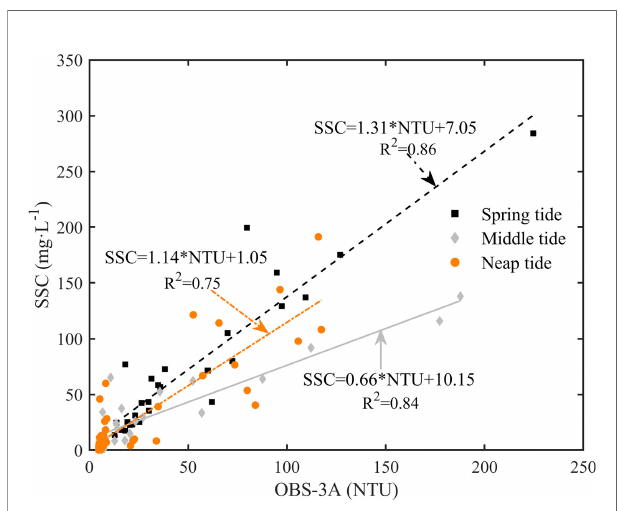
FIGURE 2 | Calibration curves to derive suspended sediment concentration ( SSC ) from an